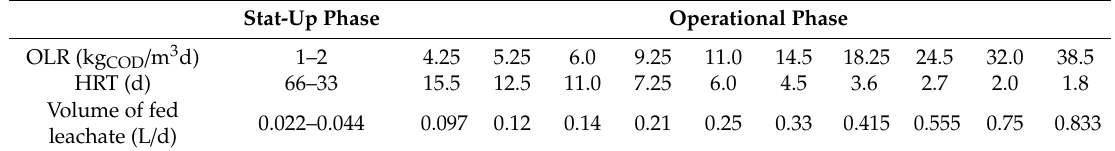
Table 1. Operational pattern of semi-continuous anaerobic digestion process. Stat-Up